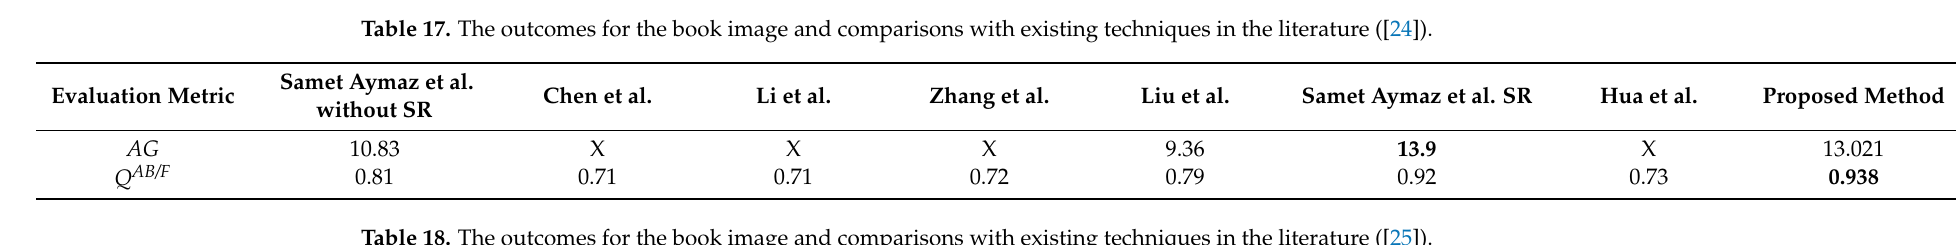
Table 18. The outcomes for the book image and comparisons with existing techniques in the litera- ture ([25]).